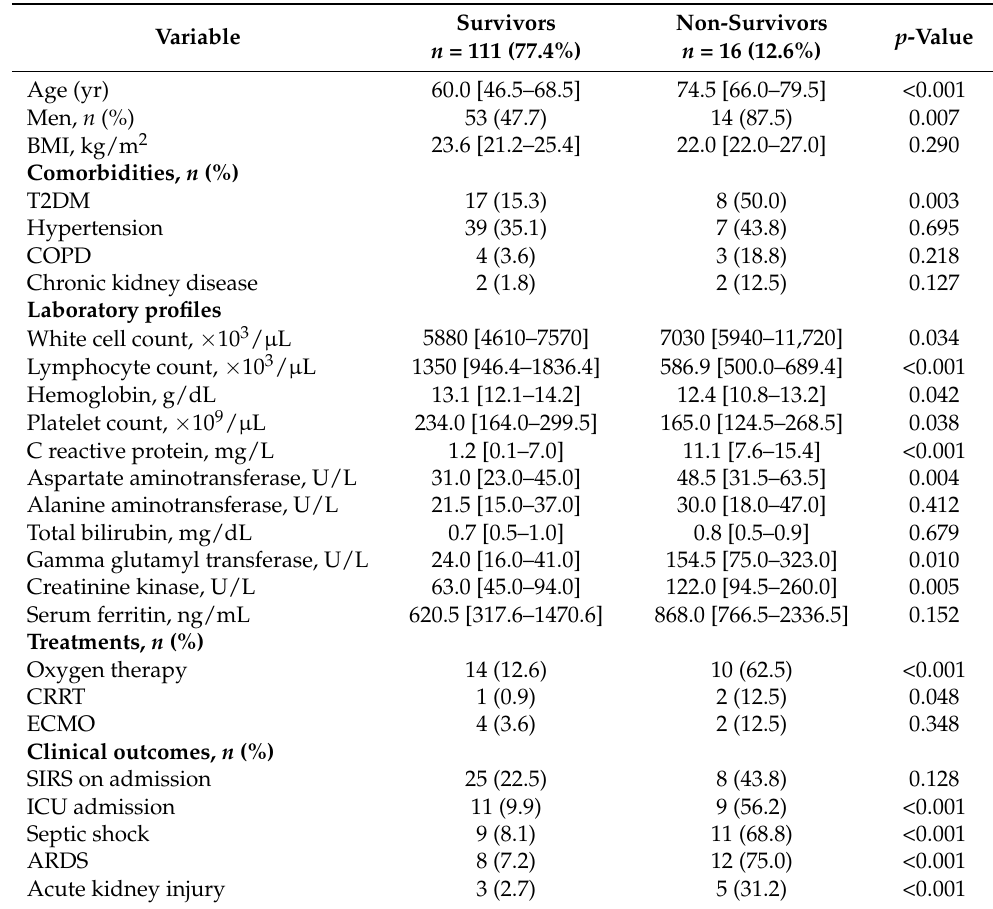
Table 2. Baseline characteristics according to